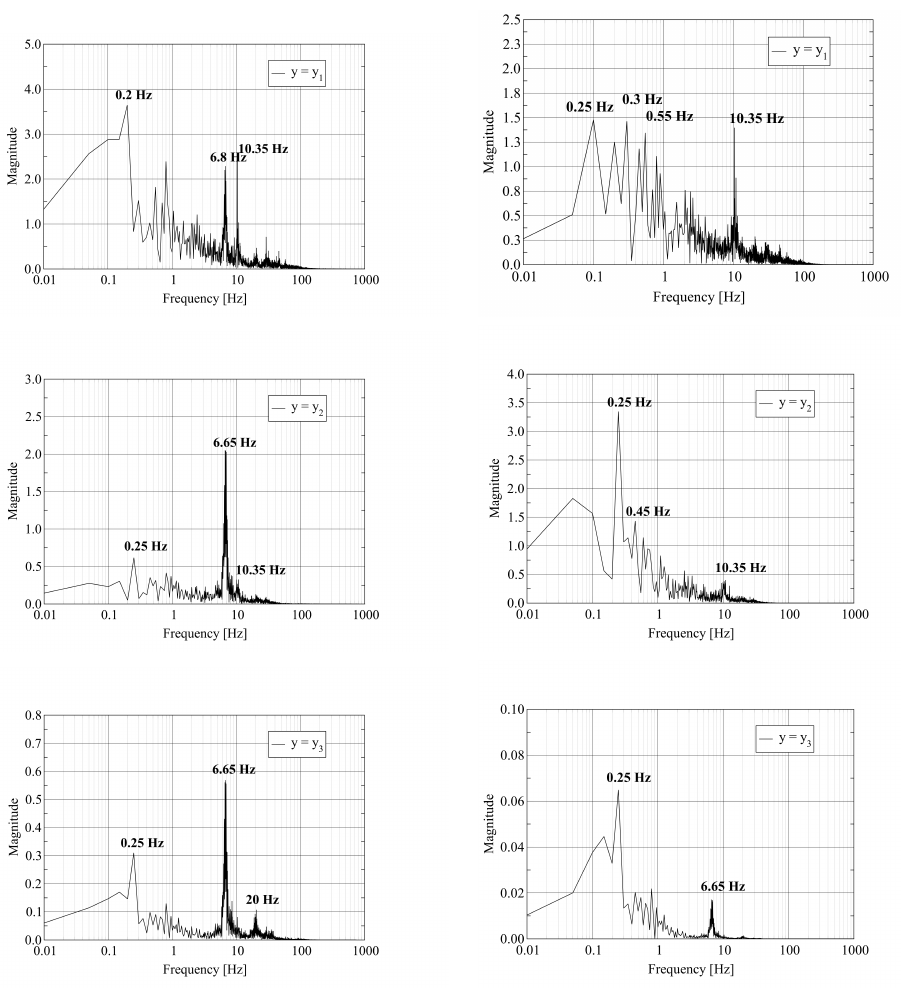
Figure 4. Discrete Fourier Transform of pressure ( left ) and y -velocity ( right ) trace at probe points located at ( 0, l i ,0 ) : where l 1 = 0.0625 L ( top ); l 2 = 0.125 L ( middle ); and l 3 = 0.9875 L ( bottom ).